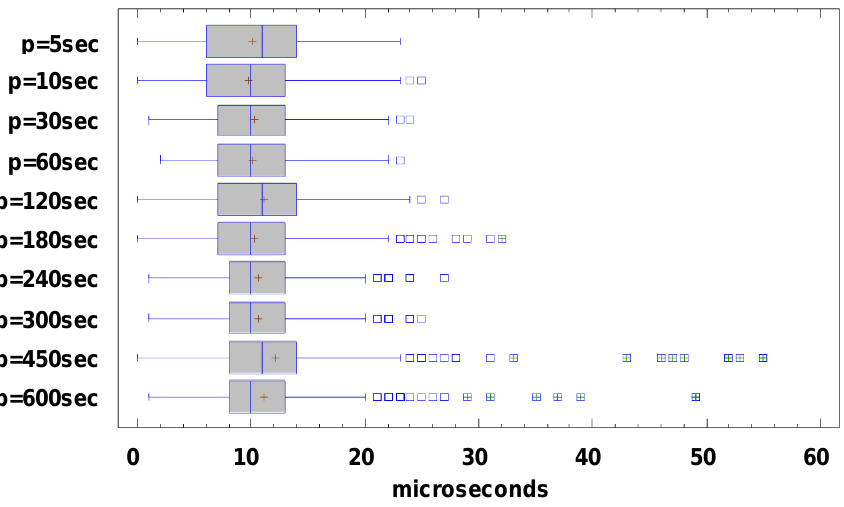
Figure 8. Boxplot graphic of the values obtained in the precision experiments.